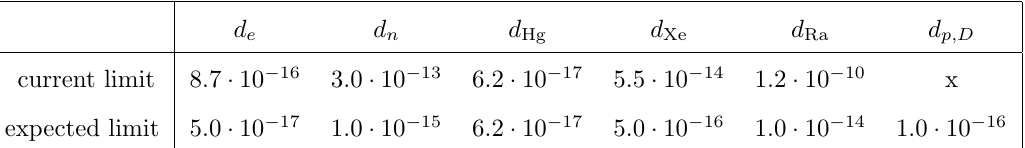
Table 9 . Current limits on the electron [116], neutron [117, 118], mercury [119, 120], xenon [121] and radium [122, 123] EDMs in units of e fm (90% con(cid:12)dence level). We also show future sensitiv- ities [124,